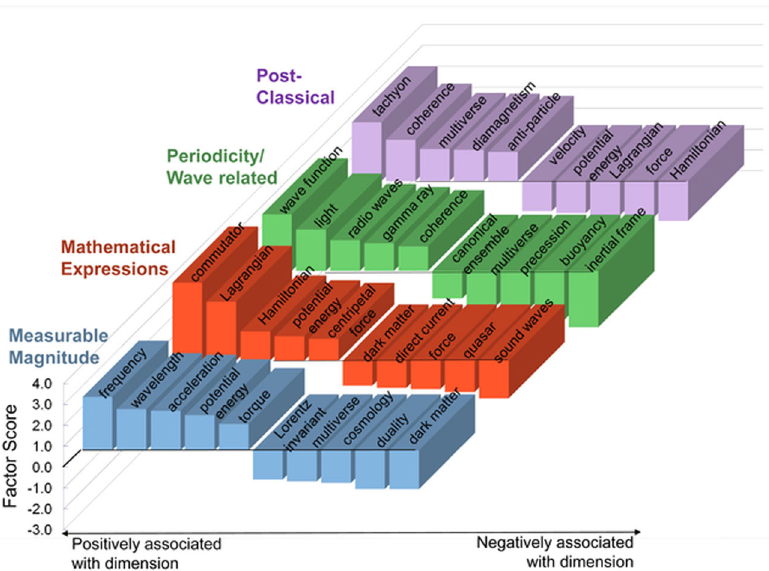
Fig. 5 Factor scores of concepts at the extremes of the four factors. A concept may have a high factor score for more than one factor; for example, potential energy appears as measurable, mathematical, and on the classical end of the post-classical dimension. In contrast, multiverse appears as non-measurable, non-periodic, and post-classical.